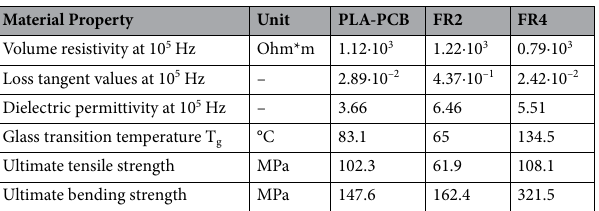
Table 1. Dielectric, mechanical and thermal characteristics of PLA-PCB, FR2 and